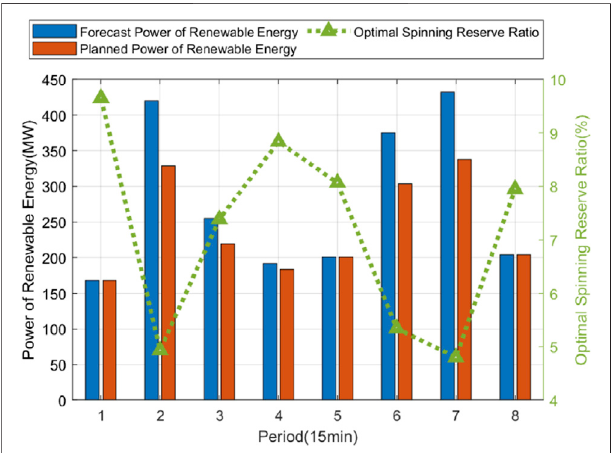
FIGURE2| ThepowernetworkusedbasedontheIEEE39-Bussystem.